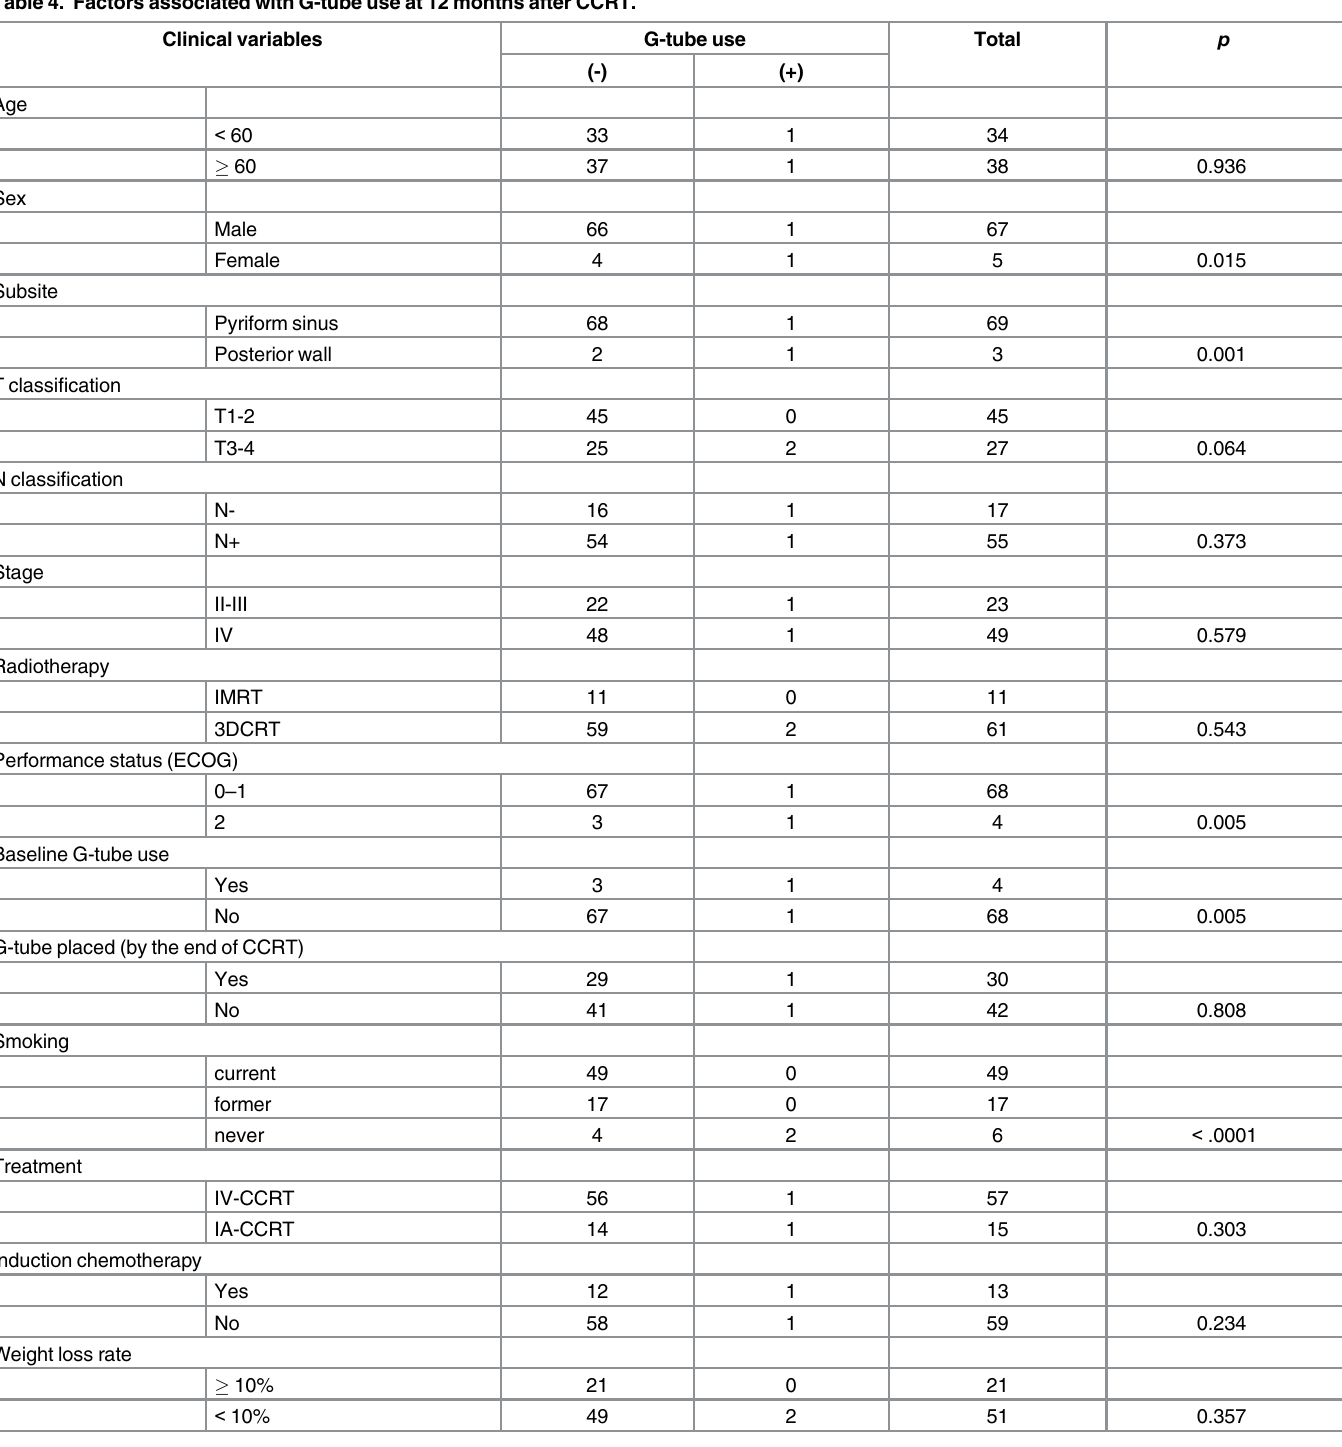
Table 4. Factors associated with G-tube use at 12 months after